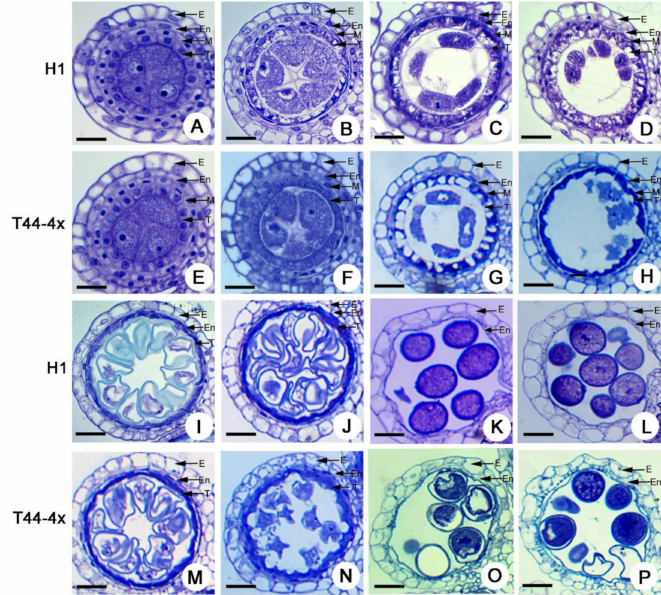
Figure 2. Semi-thin sections of H1 and its low-pollen-fertility parent T44-4x anthers. A to D, I to L Semi-thin sections of H1 anthers. ( A ) pre-meiotic interphase; ( B ) meiosis stage I; ( C ) meiosis